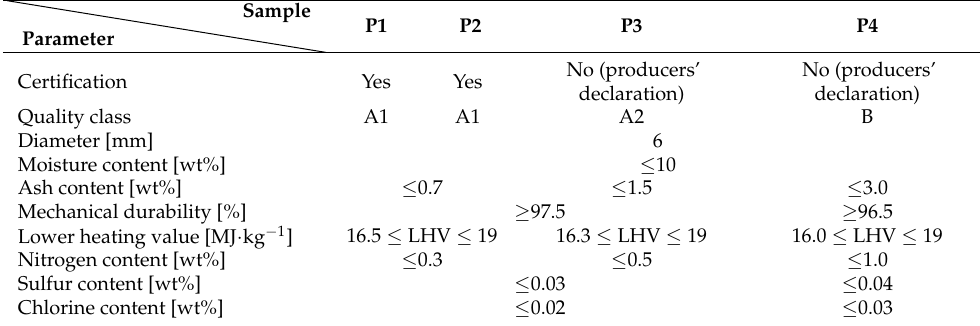
Table 1. Quality classification of tested pellets and their selected properties according to ISO 17225-